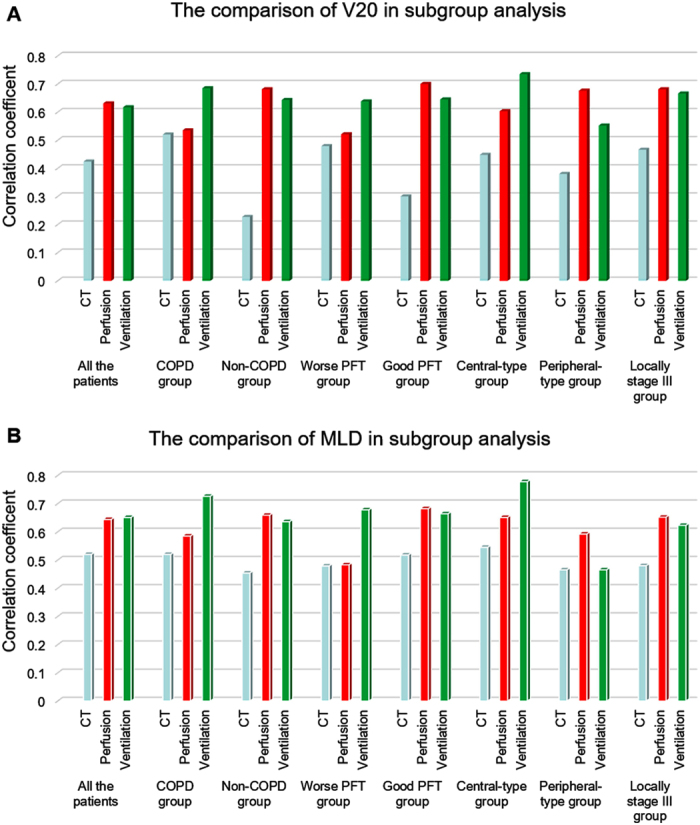
The comparison of correlation coefficient between RILT and dosimetric parameters (A, V20; B, MLD) among CT, perfusion SPECT and ventilation SPECT in subgroup analysis. RILT, radiation-induced lung toxicity; V20, relative volume of lung receiving more than 20 Gy dose; MLD, mean lung dose; CT, computerized tomography; SPECT, single-photon emission computerized tomography.